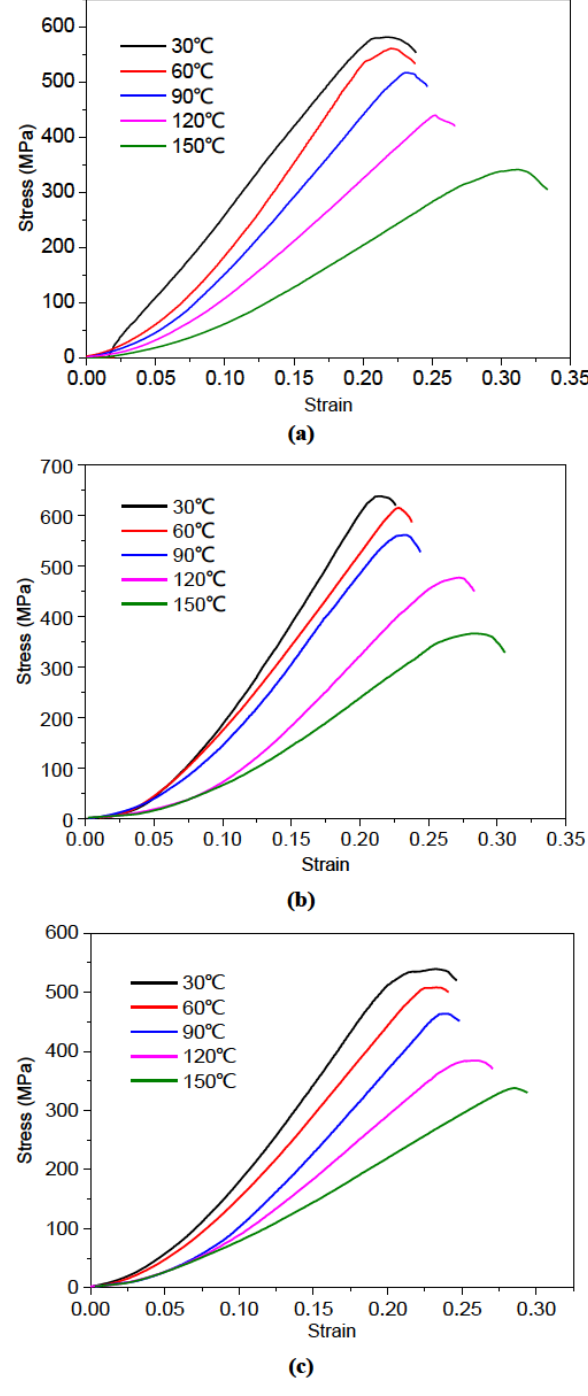
Figure 8: Out-of-plane compression stress-strain curves at different temperatures: (a) desized composite; (b) D 400 -GO-grafted compos- ite; (c) GO-grafted composite